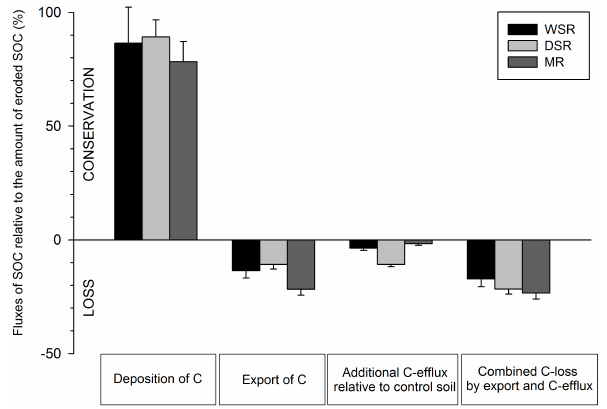
Fig. 7. Fate of eroded SOC (%) in the three simulation experiments, expressed relative to the total amount of eroded